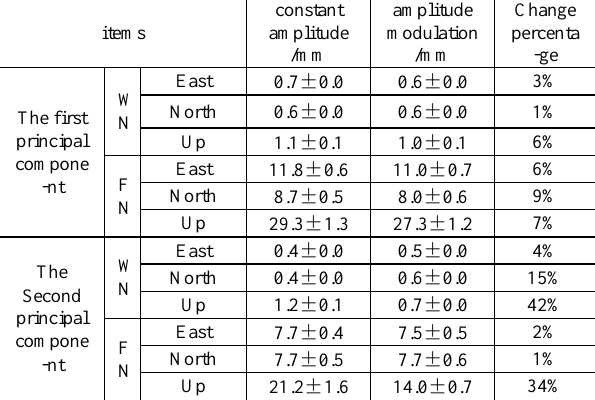
Table 1 . Noise analysis